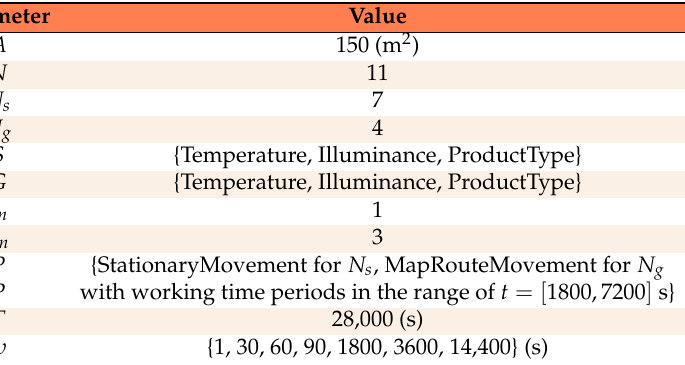
Table 1. Parameter setting for the smart office scenario.